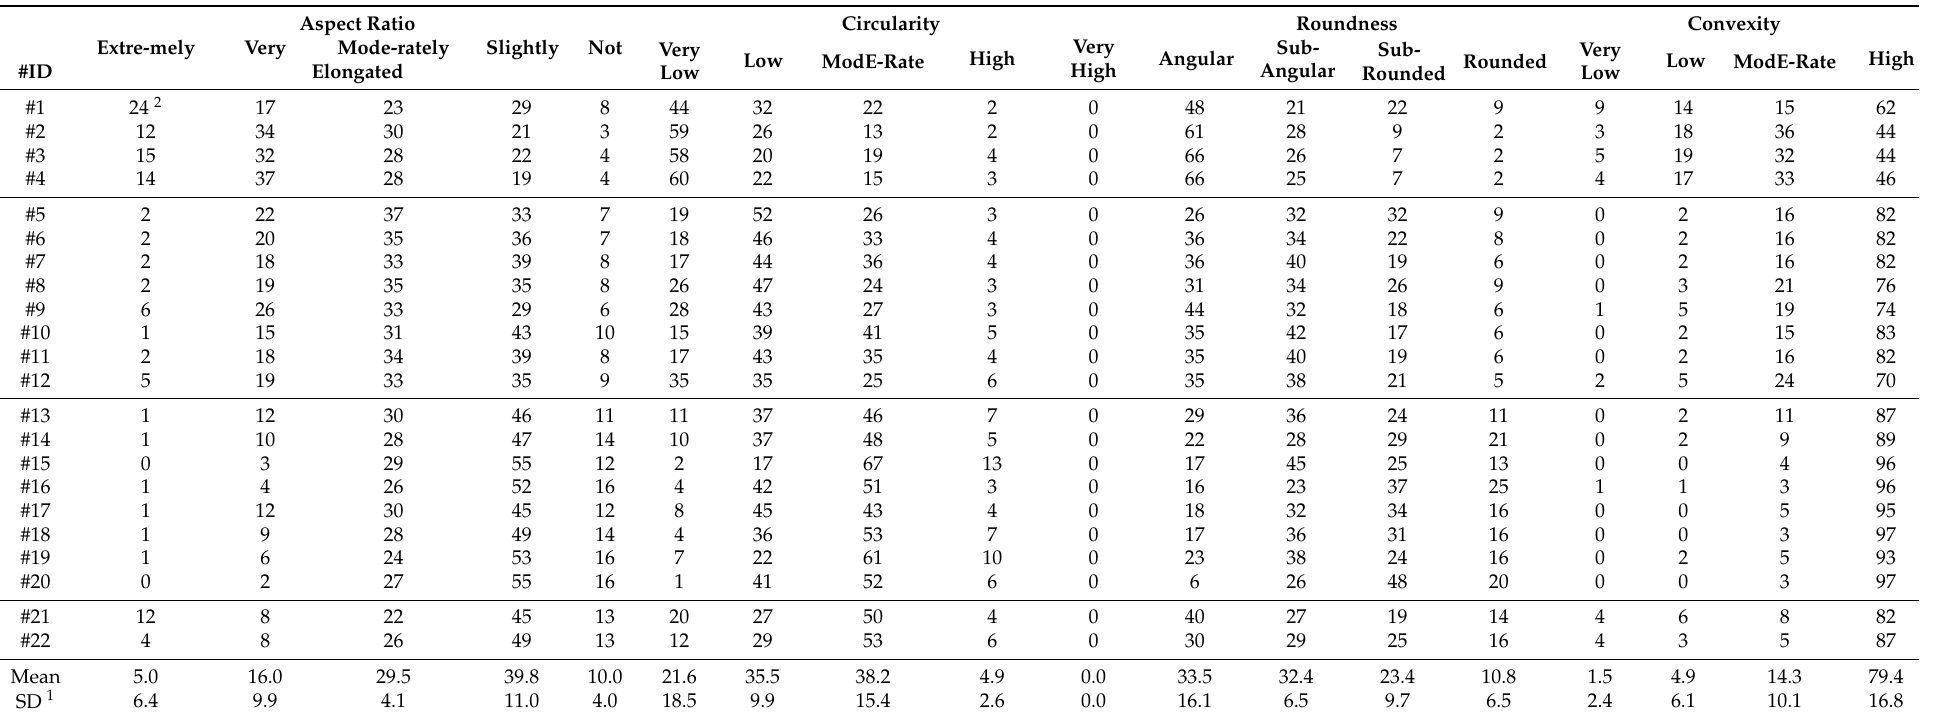
Table 3. Particle shape distribution by classes, assessed from the classification proposed for shape descriptors in Table